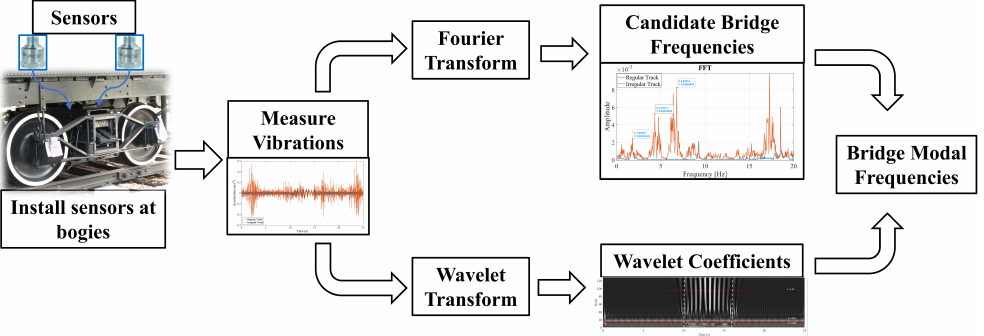
Figure 2. Flowchart of the proposed